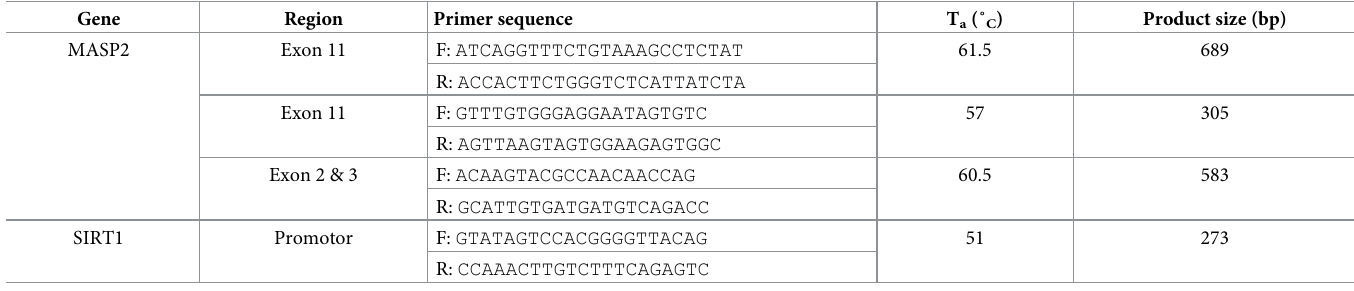
T a = Annealing temperature, bp = base pair, ˚ C = degree